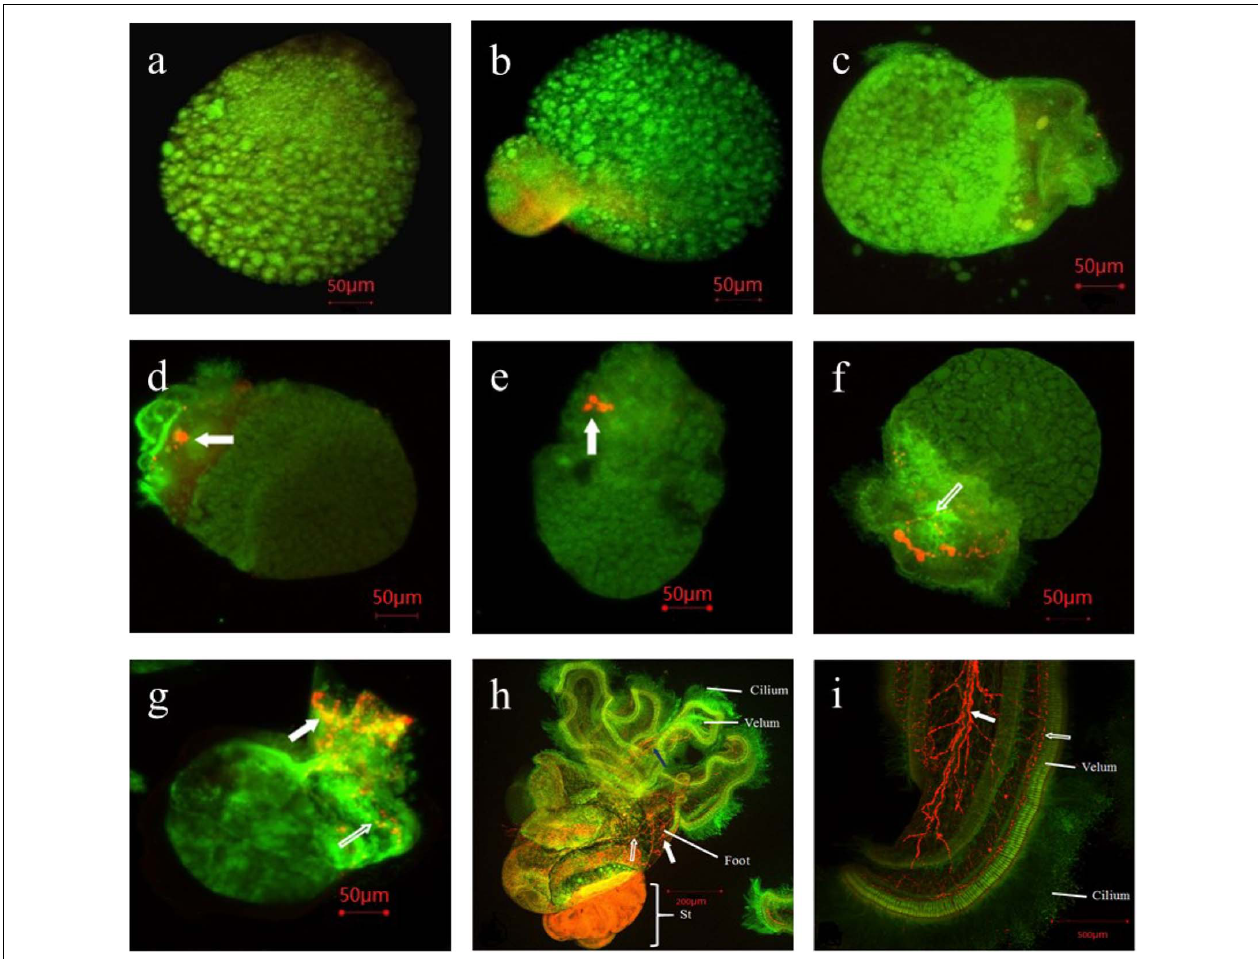
FIGURE 4 | Immunoreactivity of 5-HT and α -tublin in early development stage of Rapana venosa . [ (a) . cleavage; (b) . blastula; (c) . gastrulae; (d) . late trochophore; (e) . early intra-membrane veliger; (f) . middle intra-membrane veliger; (g) . later intra-membrane veliger; (h) . competent larval stage; (i) . velum of competent larvae]. No positive immune signals in the cleavage stage (a) , blastula stage (b) and gastrulae stage (c) . Two pairs of positive immune signals in late trochophore stage [ (d) , top organ, profile figure, only one signal is visible, as indicated by a white arrow]. Immune-positive signals increased to 5 in early intra-membrane veliger stage (e) . The 5-HT immune-positive signal extended to both cerebral nerve fibers in the middle intramembrane veliger stage [ (f) , hollow arrow]. Positive signals began to appear in the lower foot primordia of the later intramembrane veliger larvae, and a strong signal appeared at the velum [ (g) , white arrow]. The immunohistochemical analysis revealed a complex neural network in the mantle in four-spiral whorl stage larvae (competent larvae, V-IV) [ (h) , hollow arrow], foot [ (h) , white arrow] and velum [ (h) , blue arrow]. The three major nerves in the velum [ (i) , white arrow] and the receptors in the base of the ciliate [ (i) , hollow arrow] were clearly connected in a complex nerve